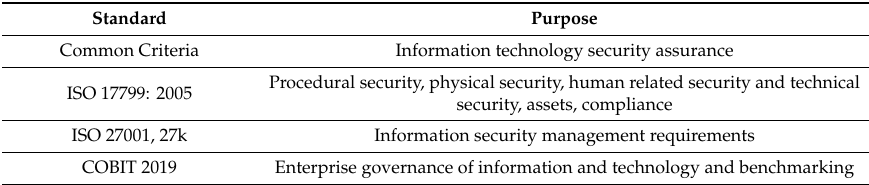
Table 1. Comparison of existing security